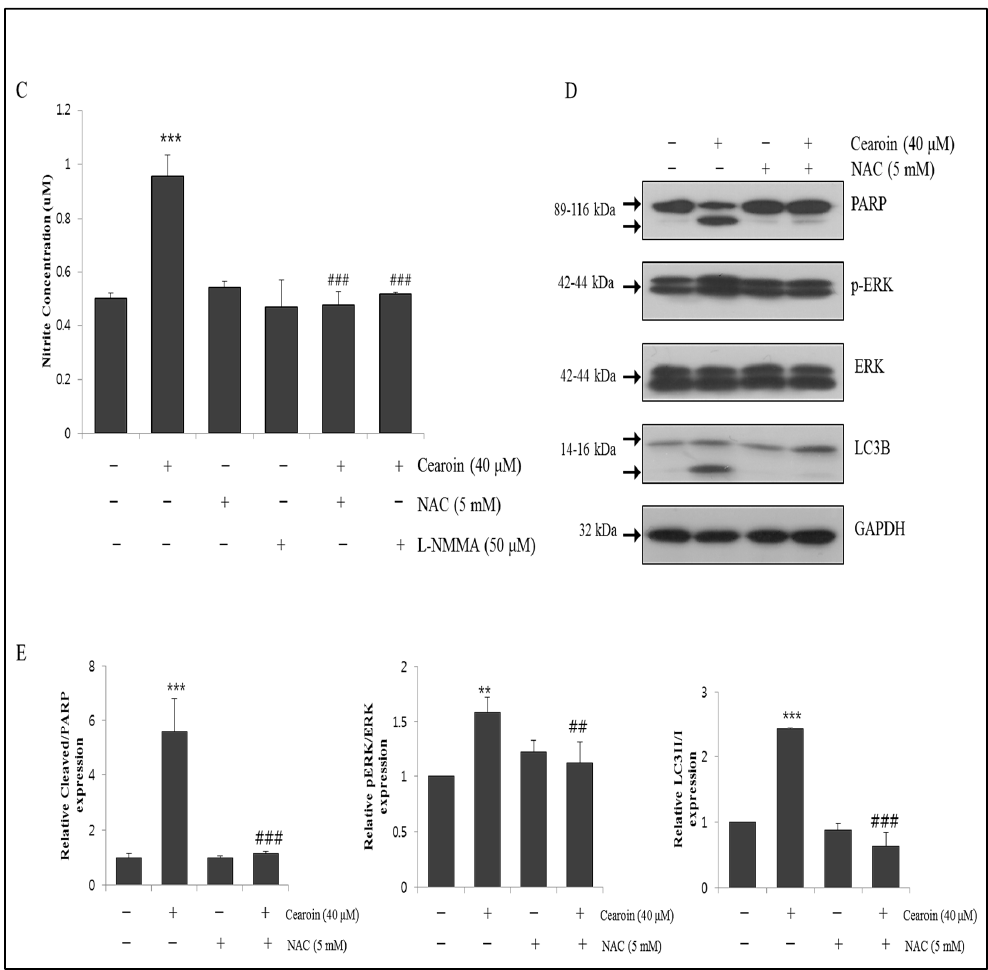
Figure 5. Antioxidant NAC completely reverses the cearoin-induced ERK activation, autophagy, and cell death in neuroblastoma SH SY5Y cells. Neuroblastoma SH-SY5Y cells were